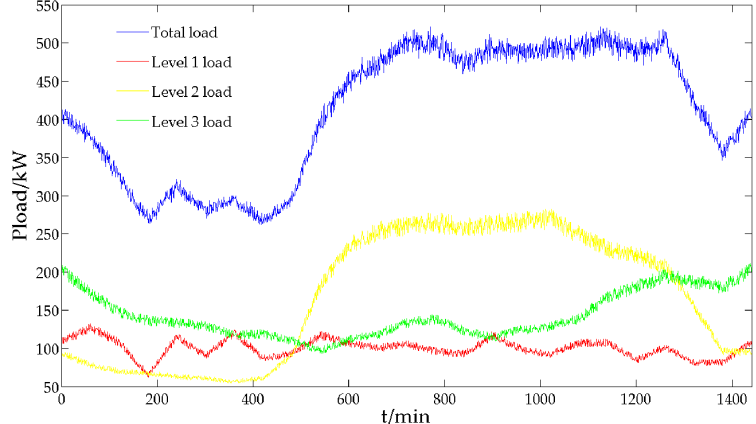
Figure 8. Typical daily load curves. Table 7. Environmental data.